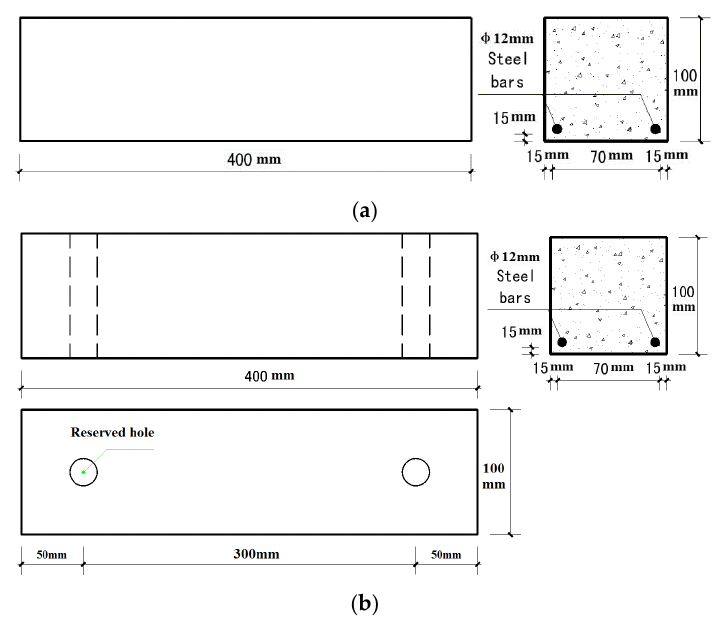
Figure 1. Details of the tested reinforced concrete specimens: ( a ) RT (the specimen under carbonation attack); ( b ) RTL (the specimen under the coupled action of carbonation and static loading).